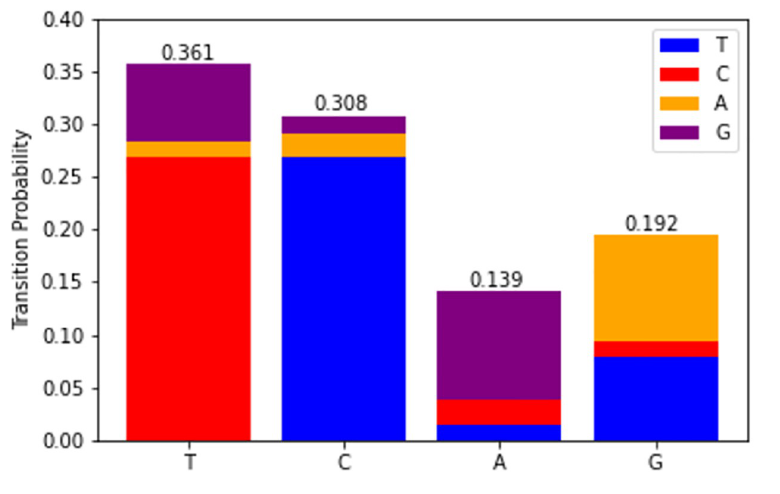
Fig 8. Markov transition probabilities.